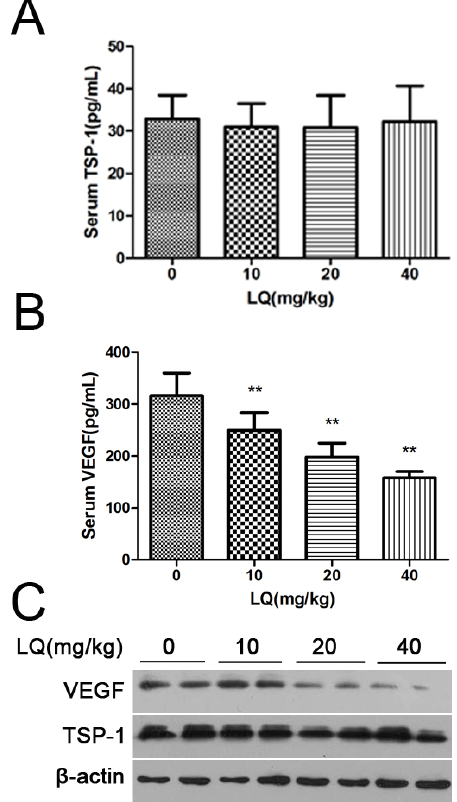
Figure 3. The effect of LQ on the expression and secretion of VEGF in Hela tumors. Serum thrombospondin-1 and VEGF concentrations were measured with ELISA kits, respectively ( A . B .). Western blotting of tumoral VEGF protein at the different doses of tumor. In mice bearing tumors, treatment with LQ let to dose-dependent suppression of tumoral VEGF levels. Values are the means ± SD (n = 3) of three individual experiments. ** p < 0.01 vs.